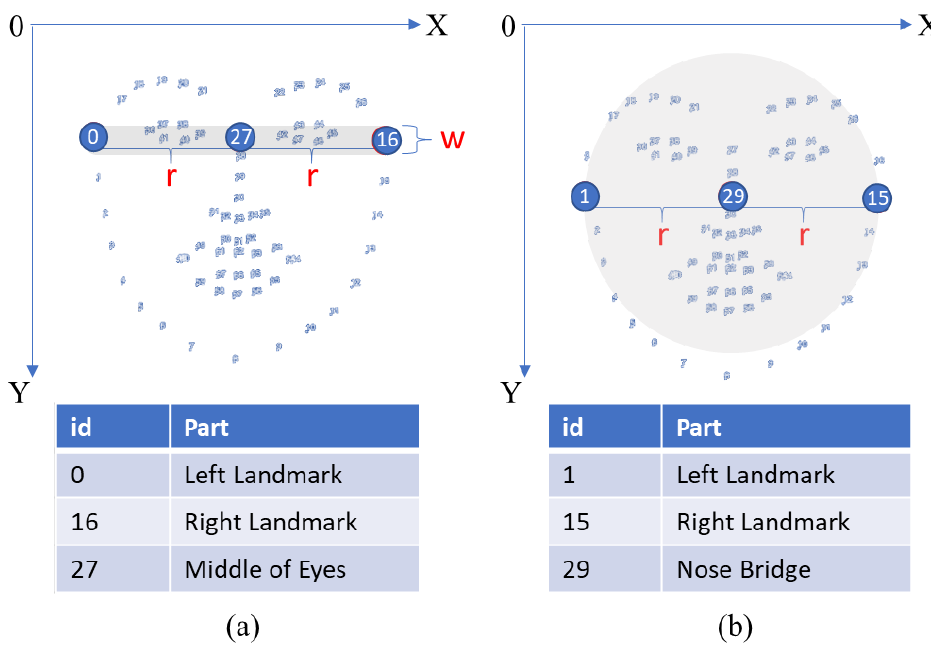
Figure 12. Approaches using face recognition: ( a ) Eye line mosaic. ( b ) Face